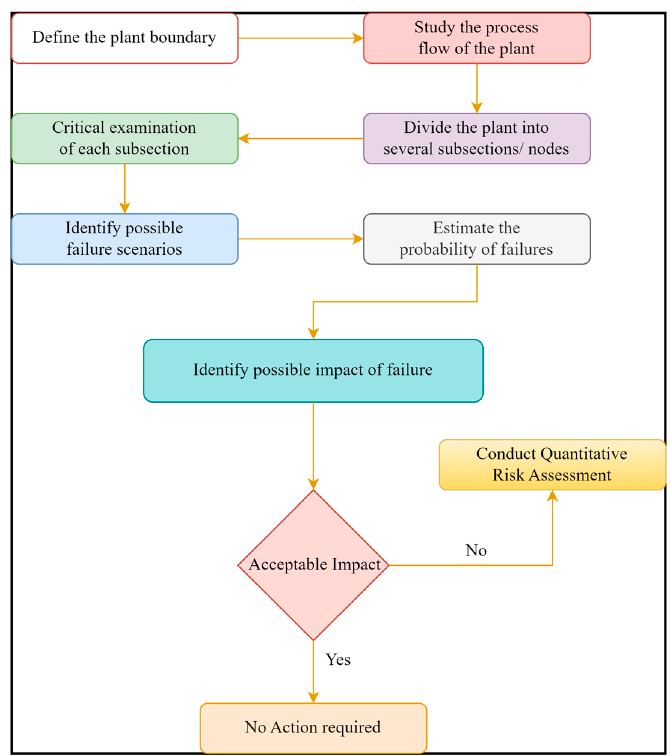
Figure 3. HAZID methodology fl owsheet .